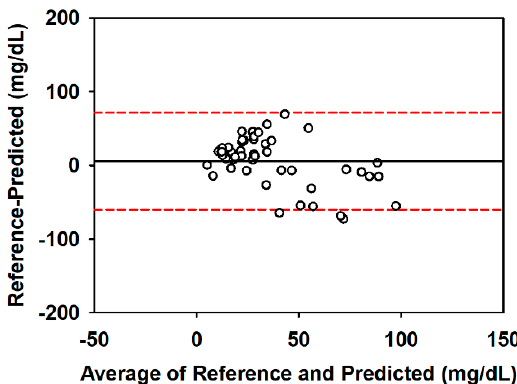
Figure 6. Bland–Altman plot by glucose-spiked and artificial tear sample, in which red dash line means of 1.96× standard deviation and black solid line stand for a mean value of the difference between reference (glucose-spiked solution assay) and predicted (artificial tear assay).